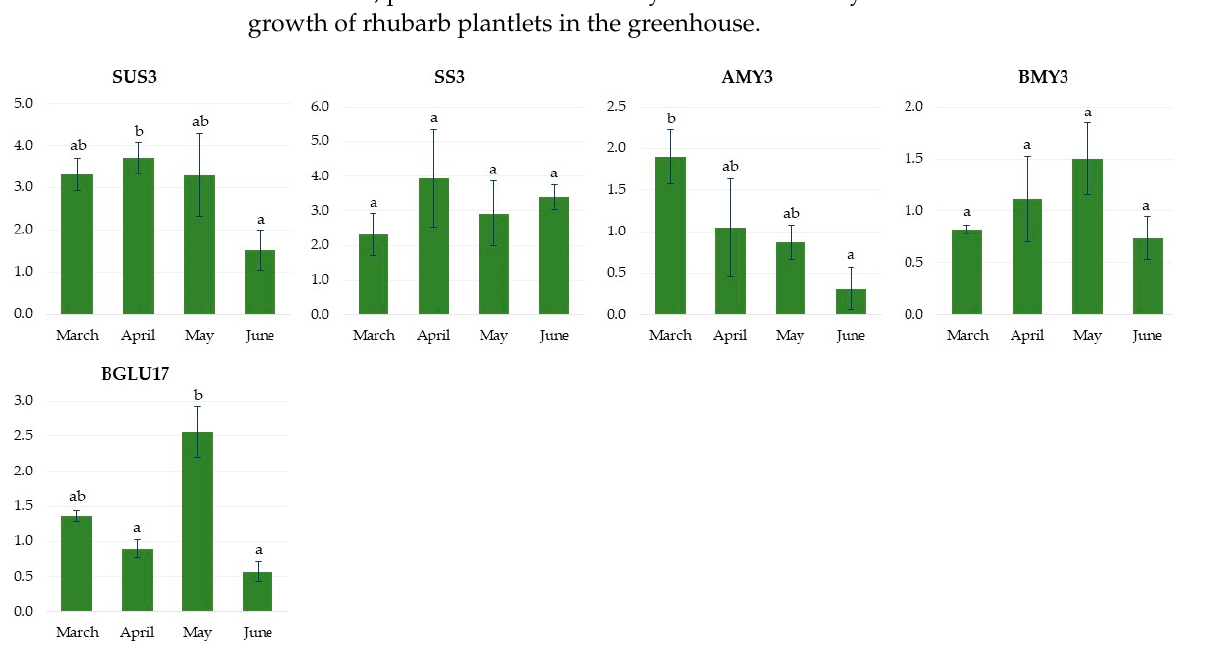
Figure 12. The relative expression of the genes involved in carbohydrate metabolism in rhubarb ‘Raspberry’ plantlets during ex vitro growth in the greenhouse from early March to the end of June. According to Duncan’s test ( p = 0.05), means marked with the same letter do not differ significantly ( p = 0.05). Error bars represent standard